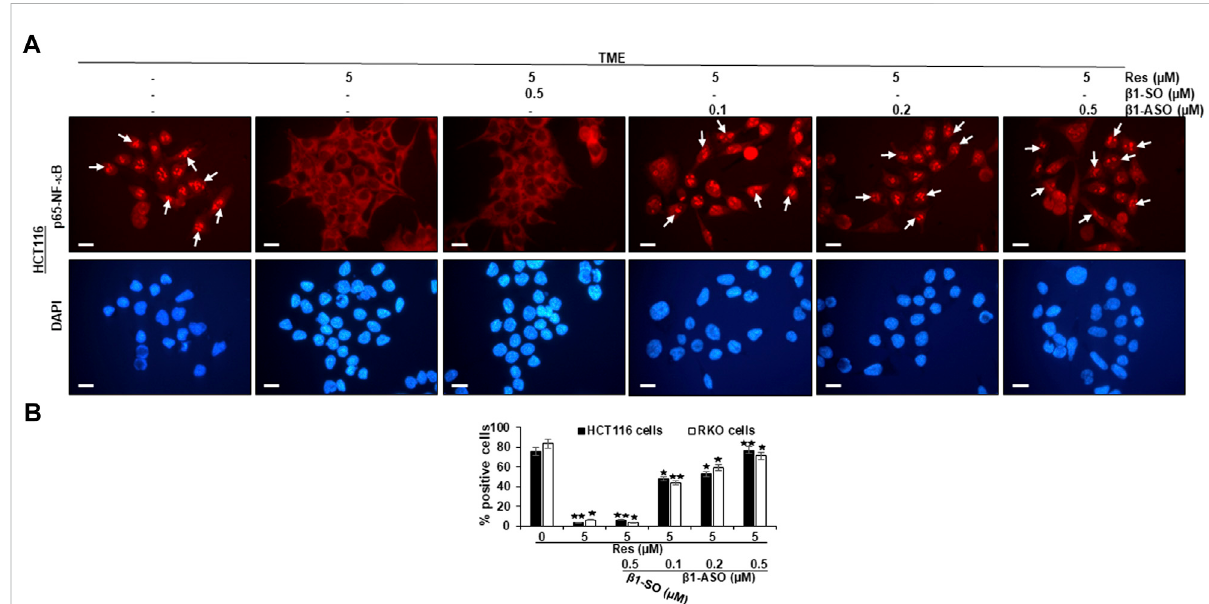
FIGURE 2 Impact of resveratrol or/and ASO against β 1-integrin on TME-mediated activation and nuclear translocation of p65-NF- κ B in CRC cells. HCT116 (A,B) and RKO (B) cells in TME on cover glasses without treatment or only treated with resveratrol (5 µM) or resveratrol-treated (5 µM) with additionof β 1-SO(0.5 µM)orknockeddownwith β 1-ASO(0.1,0.2,0.5 µM).Anti-phosho-NF- κ Bimmunolabeled(red)andDAPI-stained(blue).White arrows = p65-NF- κ B positive CRC cells. Microscope: Leica DM 2000. Magni fi cation ×600; scale bar = 30 µm. Statistical evaluation: * p < 0.05 and ** p < 0.01, compared to TME